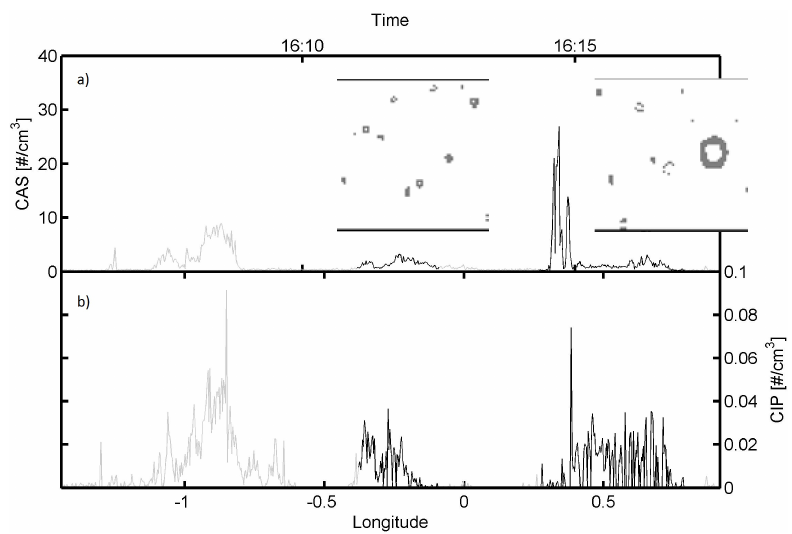
Fig. 6. Time series of (a) CAS number concentration and (b) CIP-GS number concentration for the SLR at higher altitudes (mean run tem- perature − 64°C) passing over the orbit contrails. Where black data points indicate overpass times (see text). CIP-GS images corresponding to these overpass times are also shown.